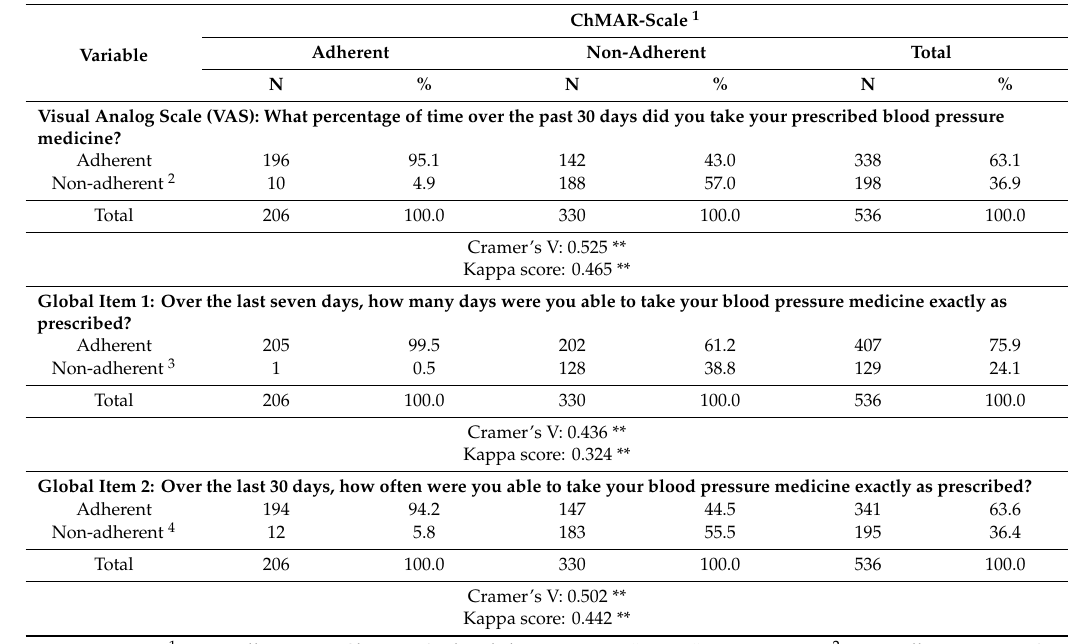
Table 3. Criterion-related validity of the